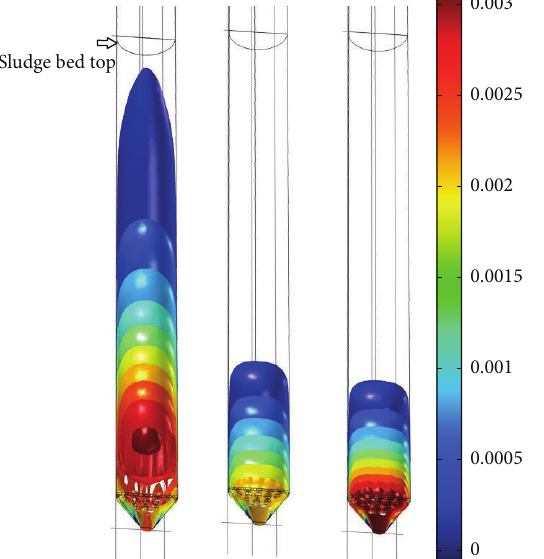
Figure 5: Distribution of VFA degradation rates in the EGSB reactor.Fromlefttoright:acetate,propionate,andbutyrate(mg/L ⋅ s).